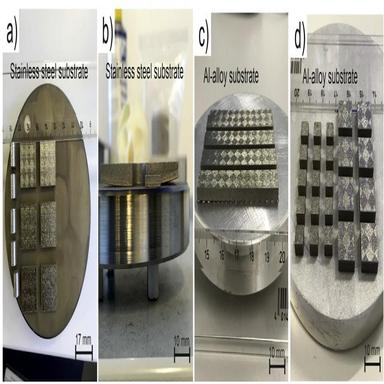
(a) Printed cuboids with an area of 17 × 17 mm2 and heights of 1, 2, and 3 mm, plus horizontal cylinders with a diameter of 6 mm and a height of 9 mm, on a stainless steel substrate. (b) Residual stress-induced sample distortion on a stainless steel substrate. (c) Printed cuboids with a size of 60 × 10 × 4 mm3 on an Al-alloy substrate. (d) Printed cuboids with an area of 10 × 10 mm2 and 5×5 mm2 and a height of 4 mm on an Al-alloy substrate.